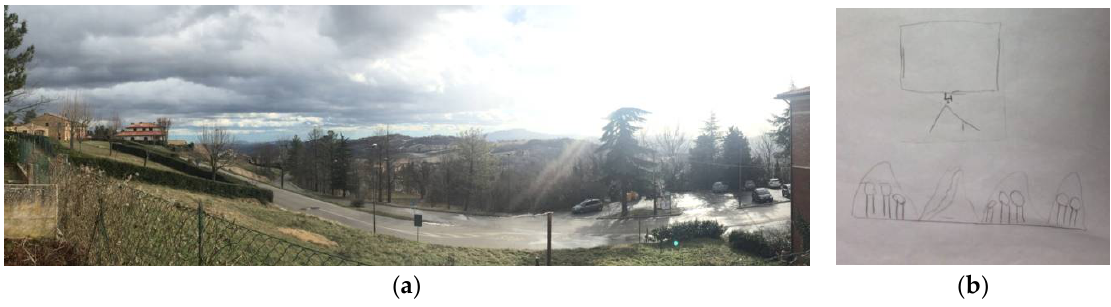
Figure 5. Gualdo and the landscape with Sibillini mountains. ( a ) The beautiful skyline from the school area, during the survey with the students (January 2017, photo IP). ( b ) The mountains with the trees and a river from a special sight-site: the school (drawing